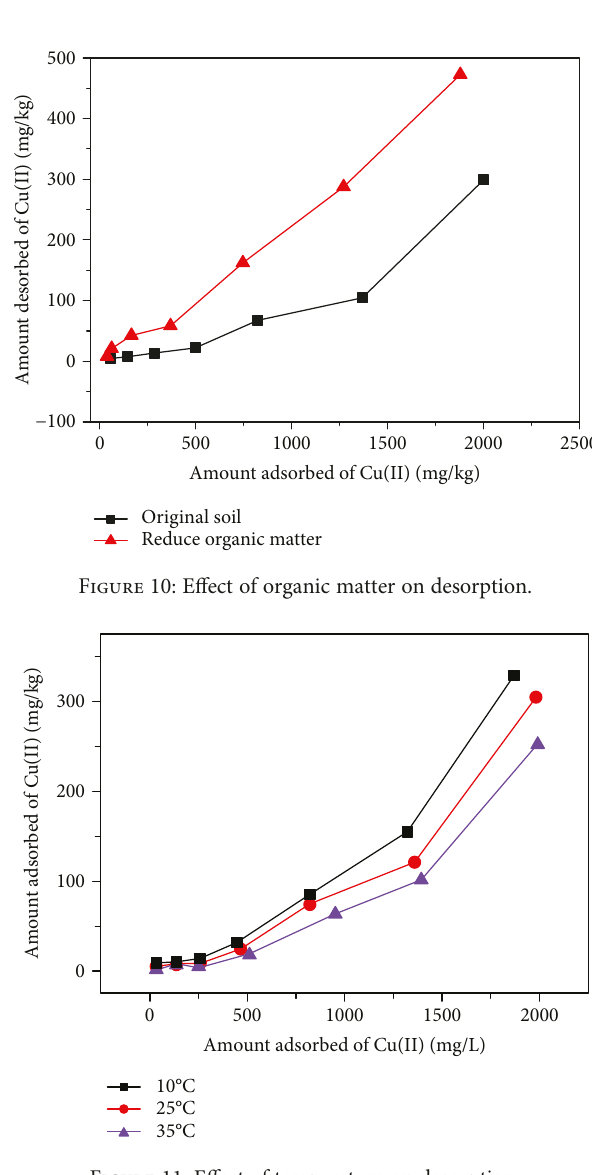
Figure 11: E ff ect of temperature on desorption.